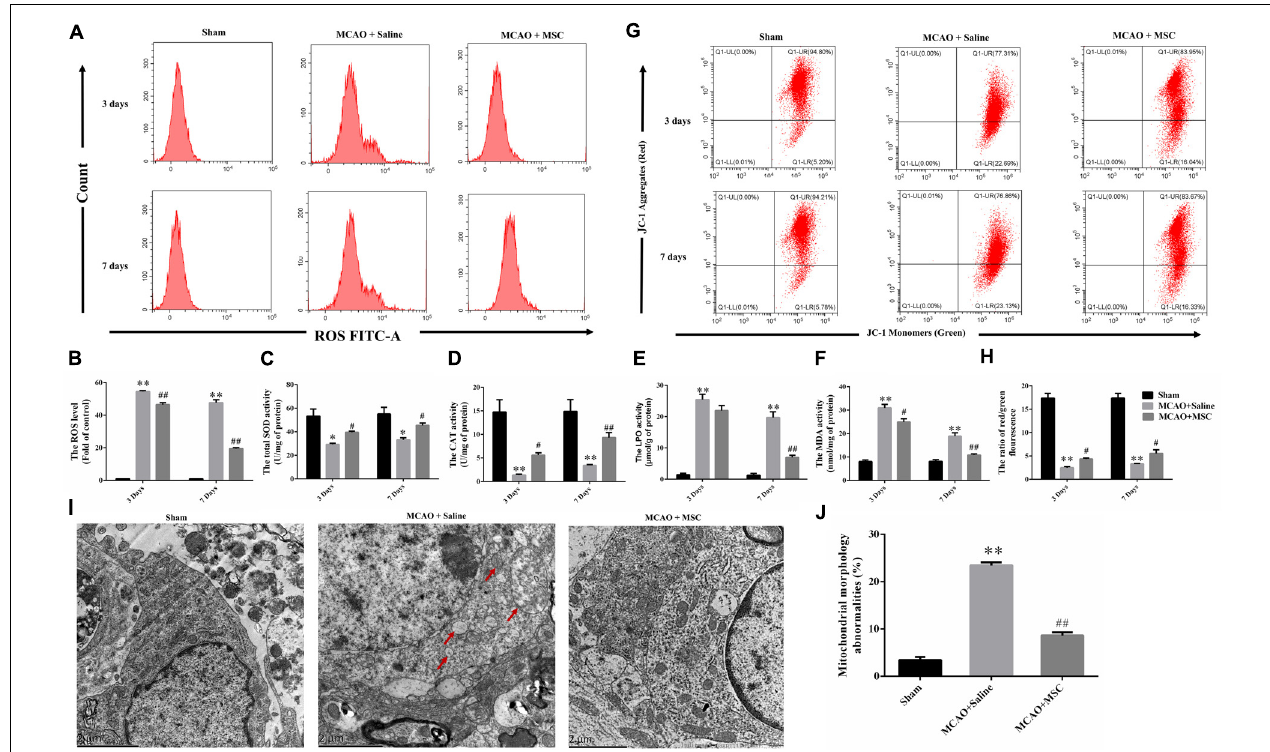
FIGURE 2 | OM-MSC administratio reduced oxidative stress level and alleviated mitochondrial dysfunction in an MCAO animal model. (A,B) ROS levels in the peri-infarct cortex were detected, and the determination was carried out using a flow cytometer. The levels were normalized by the fluorescence intensity of the control group (the value of control cells was presented as 1.0). (C–F) Measurement of antioxidative enzyme activities of CAT and SOD, and oxidative enzyme activities of LPO and MDA. (G–H) Mitochondrial membrane potential was measured using a JC-1 probe determined by flow cytometry. (I) Representative photographs of the transmission electron microscope showed ultrastructural changes in mitochondria morphology in the peri-infarct cortex and its reversal after OM-MSC treatment. In the MCAO + saline group, mitochondria with abnormal shapes, such as focal enlargement of the intermembrane space and loss of a normal cristae pattern (red arrows), were observed. (J) Based on representative photographs, quantification of aberrant mitochondria (membrane ruptures, vacuole formation) was performed. All data are displayed as mean ± SEM ( n = 3). ( ∗ P < 0.05, ∗∗ P < 0.01 vs. sham-operated, # P < 0.05, ## P < 0.01 vs. MCAO +